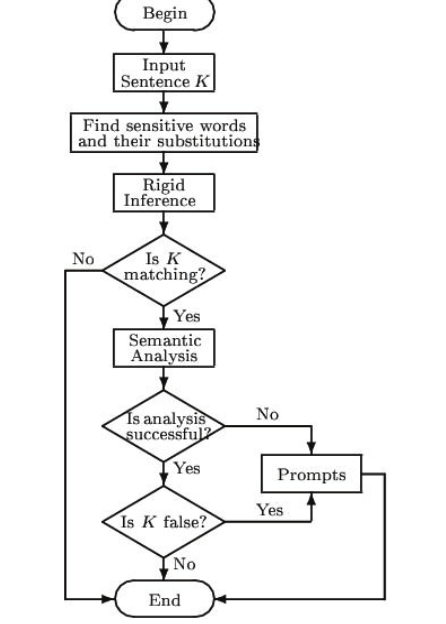
Figure 2 The new flowchart of the semantic analysis